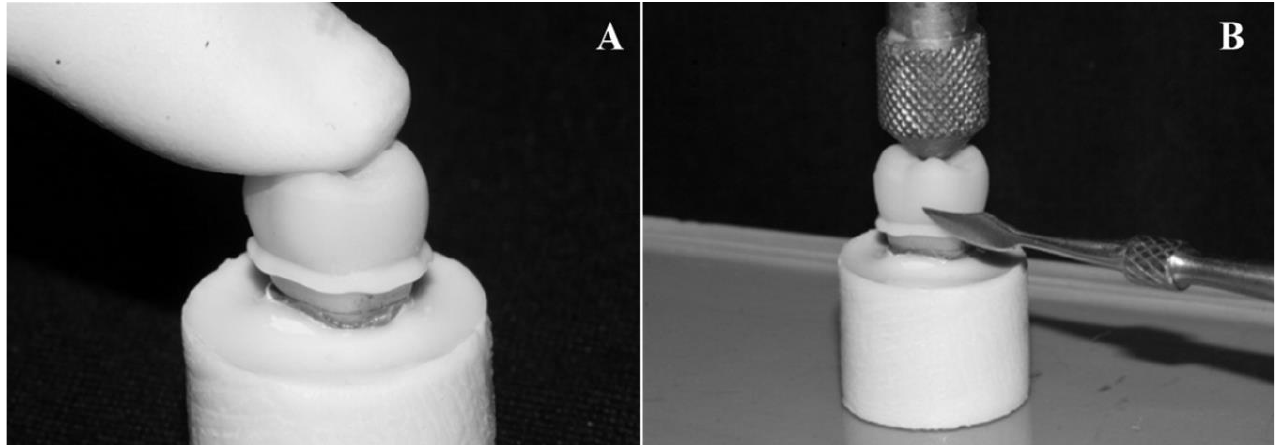
Figure 2. Luting procedure in A) Crown sitting with digital pressure and B) Excess cement